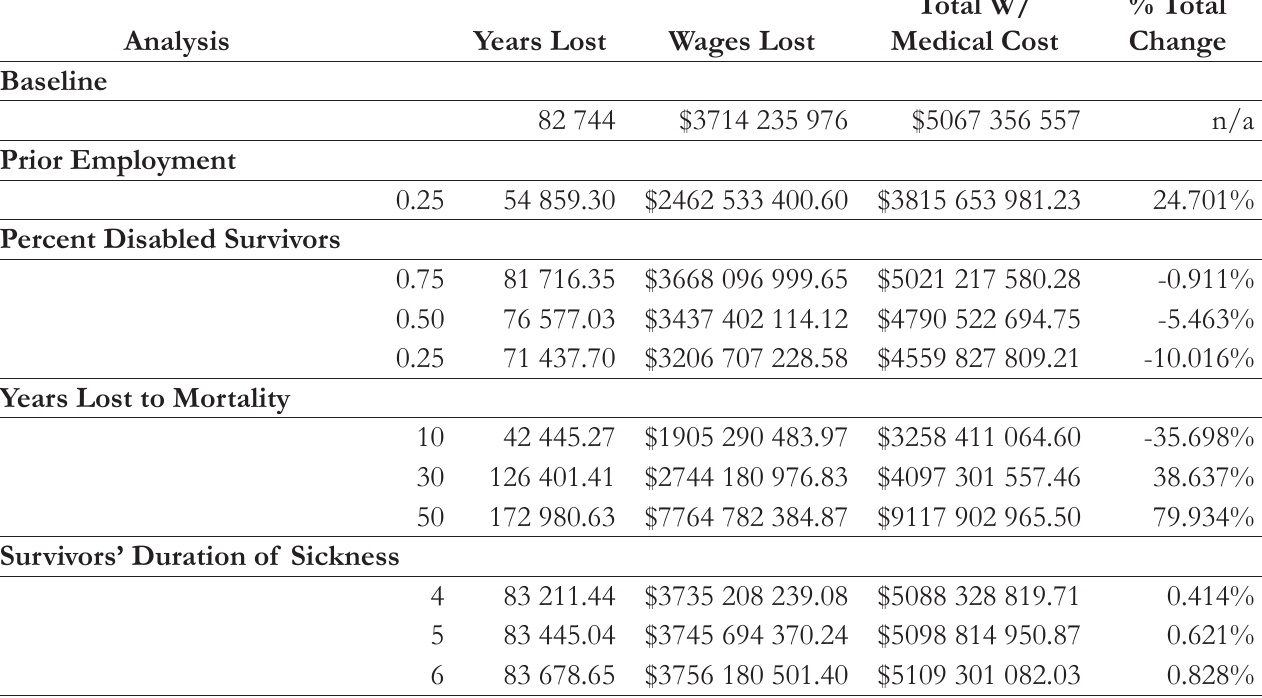
Table 2. Sensitivity Analysis Analysis Years